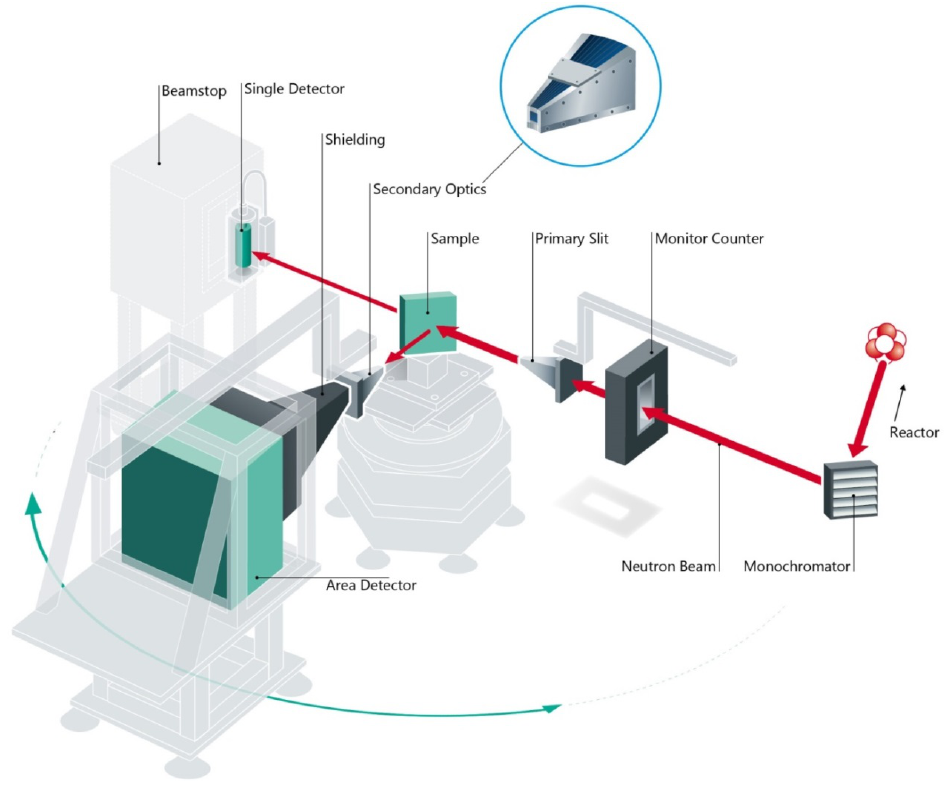
Figure 1: Schematic drawing of the E3 residual stress neutron